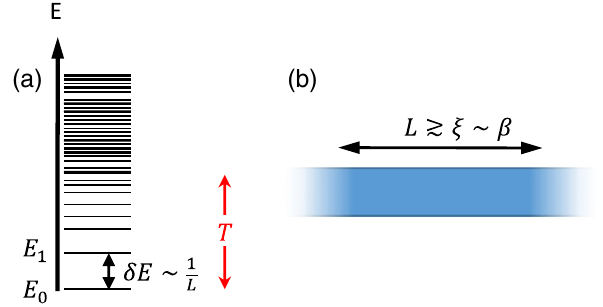
FIG. 1. (a) Finite-size spectra E s with low-energy level spacing δ E ∼ 1 =L . By requiring T > δ E for thermal averaging, this suggests L ≳ β , and therefore a thermal correlation length ξ ∼ β . (b) A large or infinite system has an effective thermal cutoff ξ ∼ β in system length when measuring local